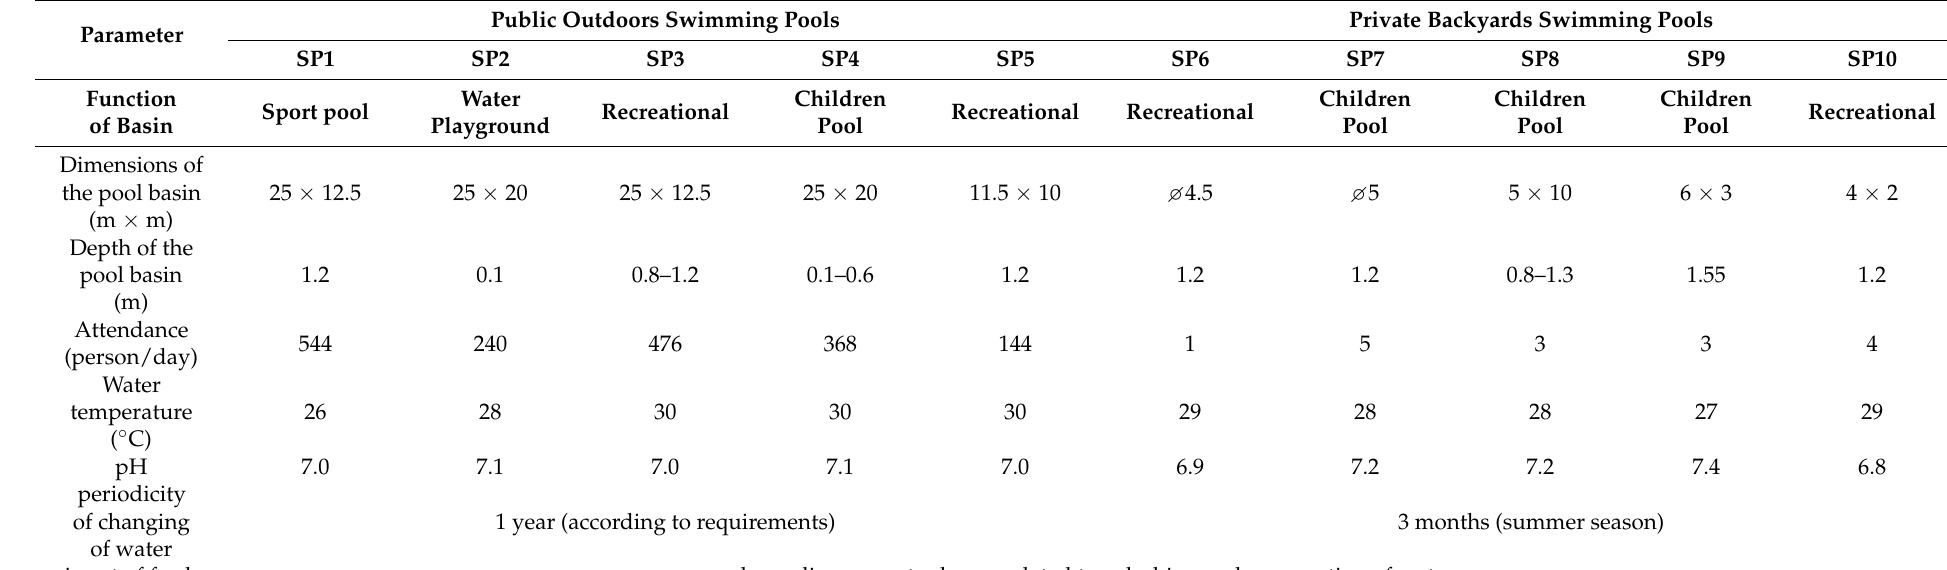
Table 1. Characteristics of the tested swimming pool